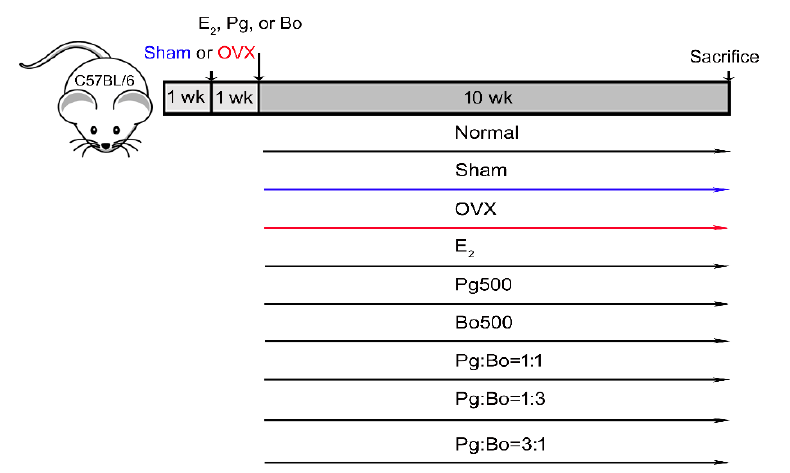
Figure 1. Treatment schedule for Pg and Bo in ovariectomized (OVX) mice. Seven-week-old female C57BL / 6 mice were acclimated to the environment for 1 week and divided into 9 groups ( n = 10 / group). Sham and OVX operations were conducted and mice were treated with 500 mg / kg / day of Pg and Bo for 10 weeks from the 1 week of operation.